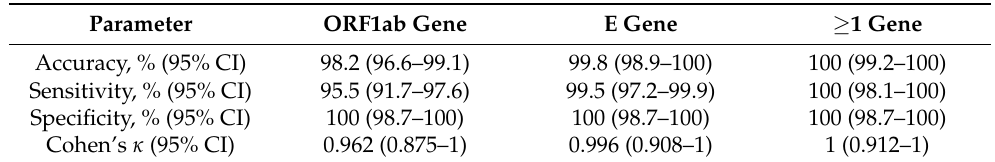
Table 3. Relative diagnostic accuracy of the STANDARD M10 assay by parameter and gene target ( n = 500).